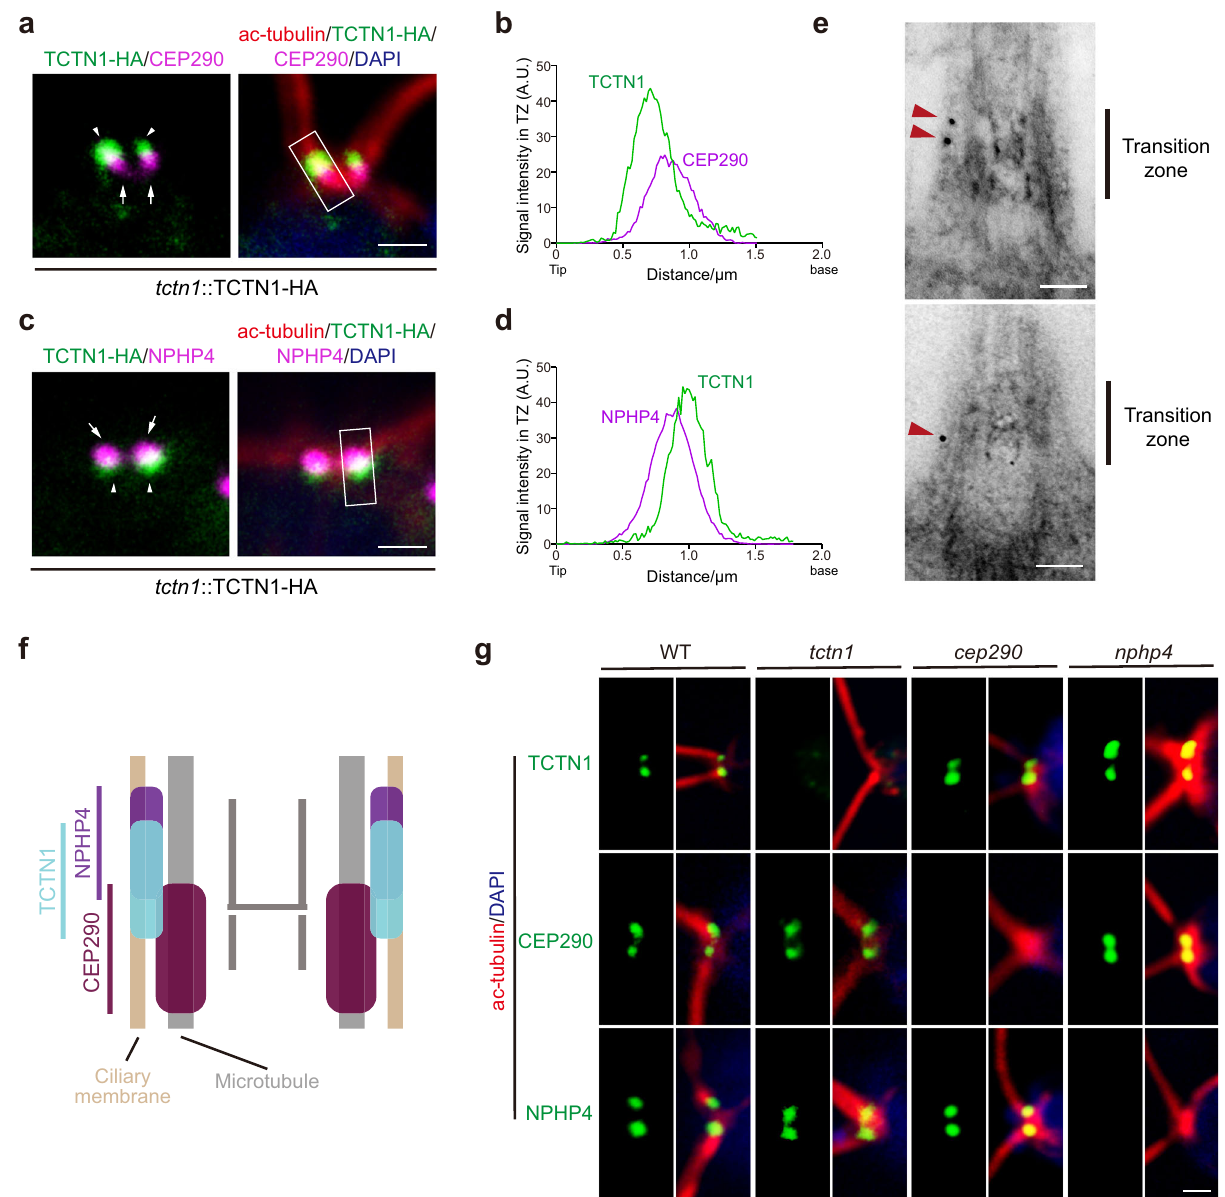
Fig. 3 TCTN1 is located between CEP290 and NPHP4 independently. a – d Immunostaining images and graphs depicting the colocalization of TCTN1 and NPHP4/CEP290. The rescued cells expressing TCTN1-HA were immunostained with anti-acetylated α -tubulin (ac-tubulin, red), anti-HA (green), and anti- CEP290 ( a , magenta) or anti-NPHP4 ( c , magenta) antibodies. The nucleus was stained with DAPI (blue). The arrowheads and arrows indicate the localization of TCTN1-HA and CEP290 ( a )/NPHP4 ( c ), respectively. The scan plots of the rectangular gray value in the merged image show the relative intensities (arbitrary units, A.U.) of the indicated proteins in the TZ. Scale bar, 1 μ m. e TEM imaging showing the longitudinal sections of TCTN1 – HA transition zones labeled with anti-HA (10-nm gold, red arrowheads). Scale bar, 0.1 μ m. f Schematic of the localization of TCTN1, CEP290, and NPHP4 at the TZ. g Immunostaining depicting the TZ localization of TCTN1, NPHP4, and CEP290 in WT, tctn1 , cep290 , and nphp4 cells. Cells as indicated were immunostained with anti-acetylated α -tubulin (ac-tubulin, red), anti-TCTN1/CEP290/NPHP4 (green) antibodies. The nucleus was stained with DAPI (blue). Scale bar, 1 μ